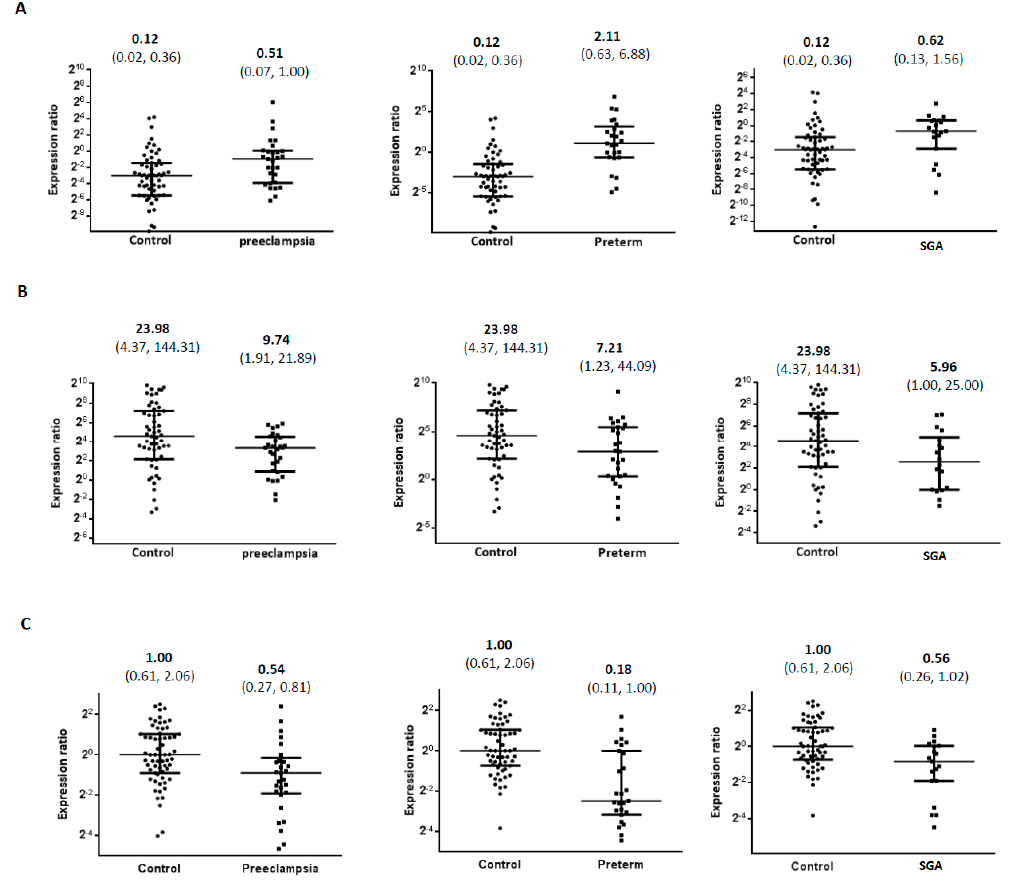
Figure 1. Comparison of miR-346 expression levels between compromised and healthy pregnancies in three gestational specimens. MiR-346 expression levels [median (interquartile range)] of maternal plasma ( A ) are significantly higher in every adverse obstetric outcome group (preeclampsia, preterm delivery, and small for gestational age) evaluated in this study (all p values < 0.05), whereas its expression levels in fetal cord plasma ( B ) and in the placenta ( C ) are lower in the adverse obstetric outcome groups.